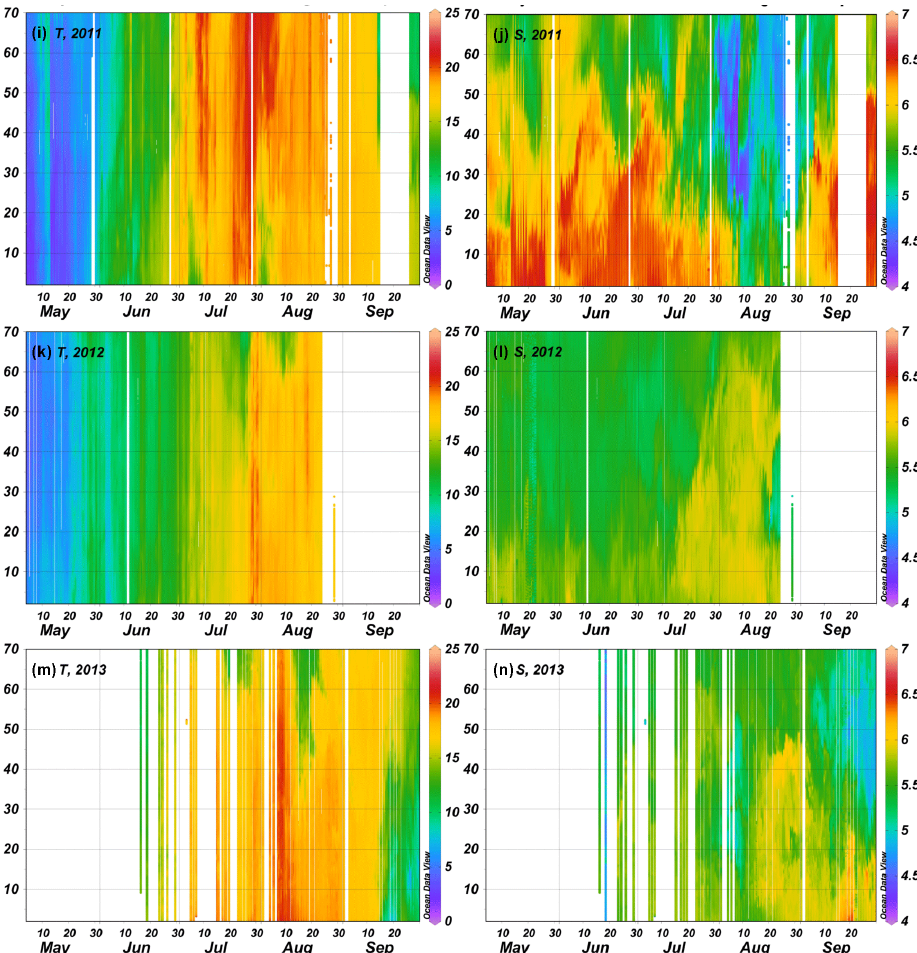
Figure 2. Temporal changes in temperature (in ◦ C) and salinity (in gkg − 1 ) distributions between Tallinn and Helsinki from 1 May to 30 September in 2007 (a, b) , 2008 (c, d) , 2009, (e, f) , 2010 (g, h) , 2011 (i, j) , 2012 (k, l) and 2013 (m, n) ; y axis shows the distance from Tallinn Bay (latitude 59.48N) in km along the meridional transect. Maps are made using Ocean Data View software (Schlitzer,